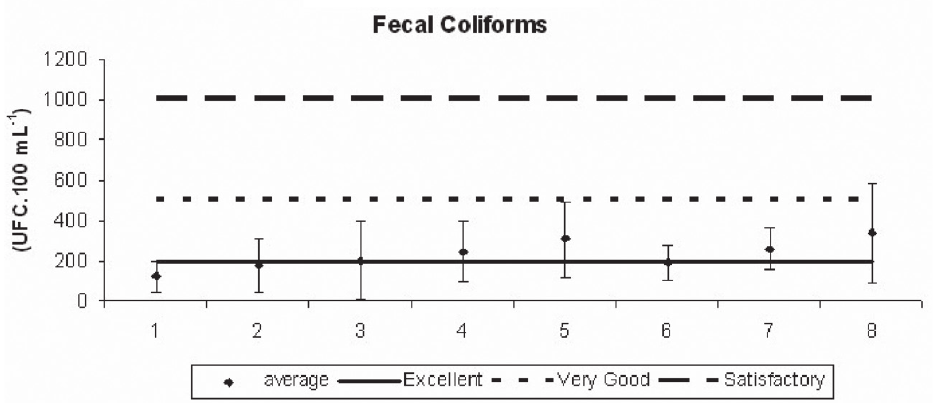
Figure 7 - Average values and standard deviation of the fecal coliforms concentrations for each sampling point at length of the Rio da Serra Basin. The lines limit the ranges established by the CONAMA 357/05 as Satisfactory, Very well and Excellent (Brasil 2005).